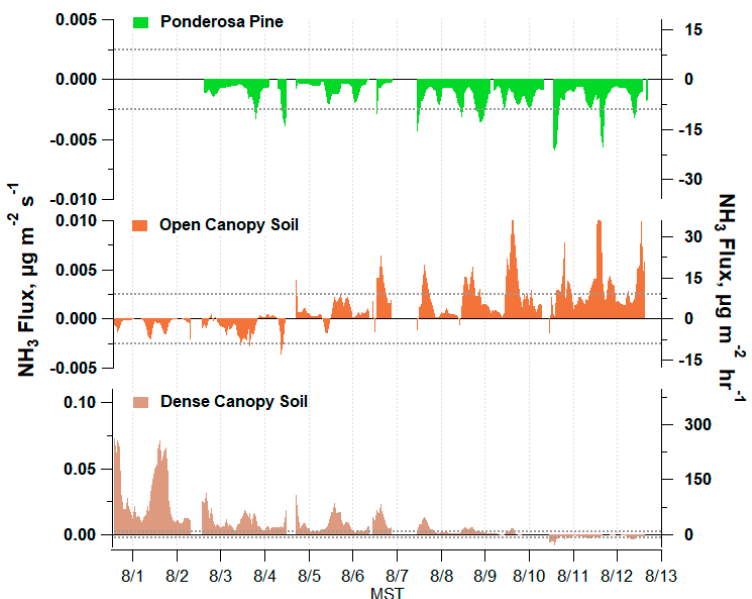
Figure 6. Inferred soil NH 3 fluxes based on χ g of both soil types and the Ponderosa pine flux (sum of stomatal and cuticular pathways) from 31 July to 12 August 2015 in µ g m − 2 s − 1 and µ g m − 2 h − 1 . Both ± 0.0025 µ g m − 2 s − 1 or 9 µ g m − 2 h − 1 are marked with grey dotted line for reference.